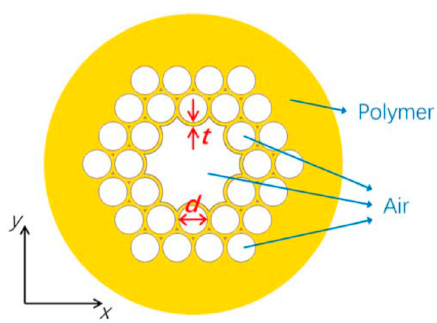
Figure 8. Cross section of the Kagome lattice hollow-core PCF. Reprinted with permission from [44]. Copyright 2017 Optical Society of America.